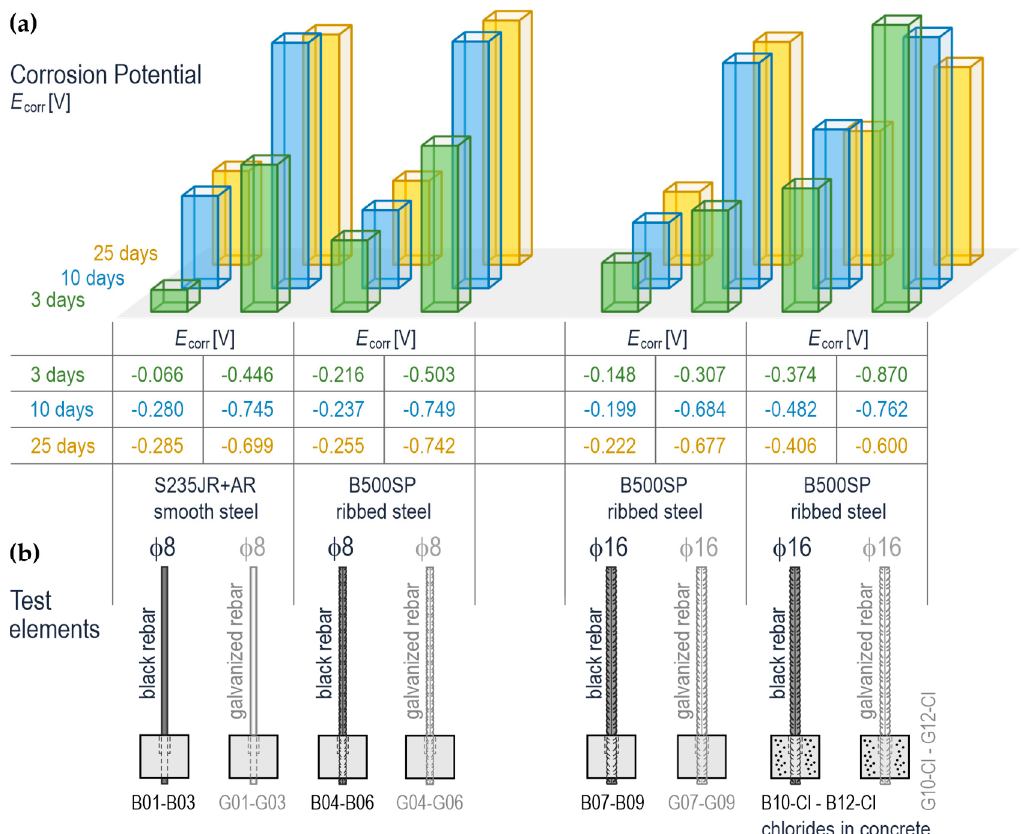
Figure 8. The results from electrochemical tests on reinforcing steel in concrete on days 3, 10, and 25 from setting the specimens in concrete: ( a ) corrosion potential E corr averaging from three specimens ( b ) the test elements with galvanized and black reinforcing steel (smooth ϕ 8 mm and ribbed ϕ 8 and ϕ 16 mm) in concrete with and without chlorides.